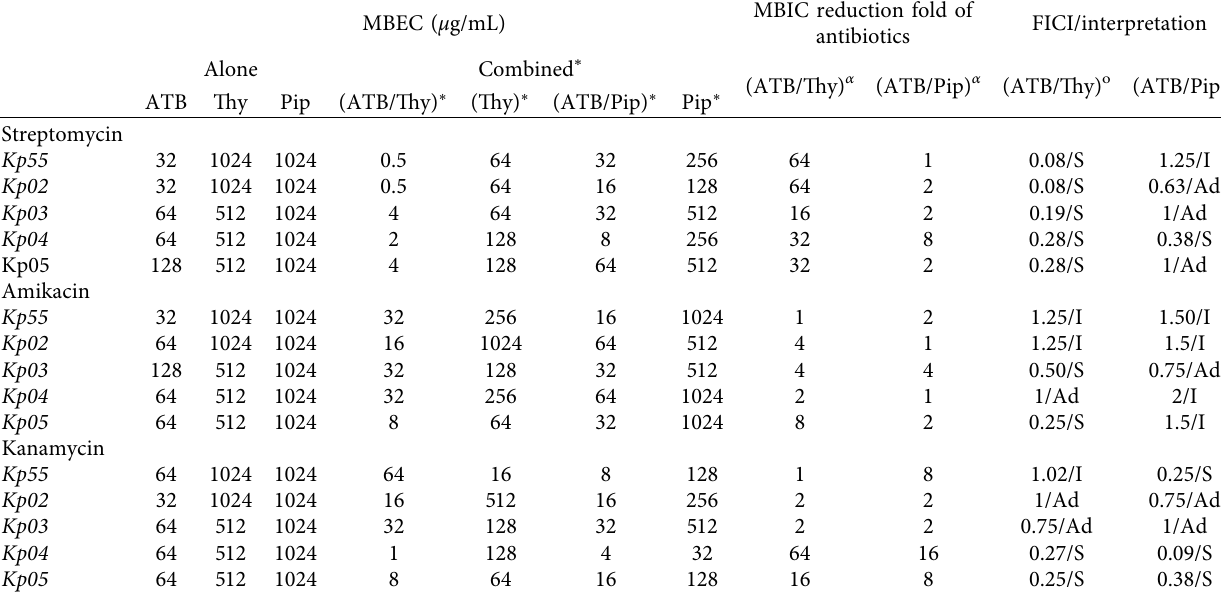
Table 3: Minimum biofilm eradication concentration (MBEC) of thymol, piperine, aminoglycoside, and fractional inhibitory concentration index (FICI) of combination against K. pneumoniae.